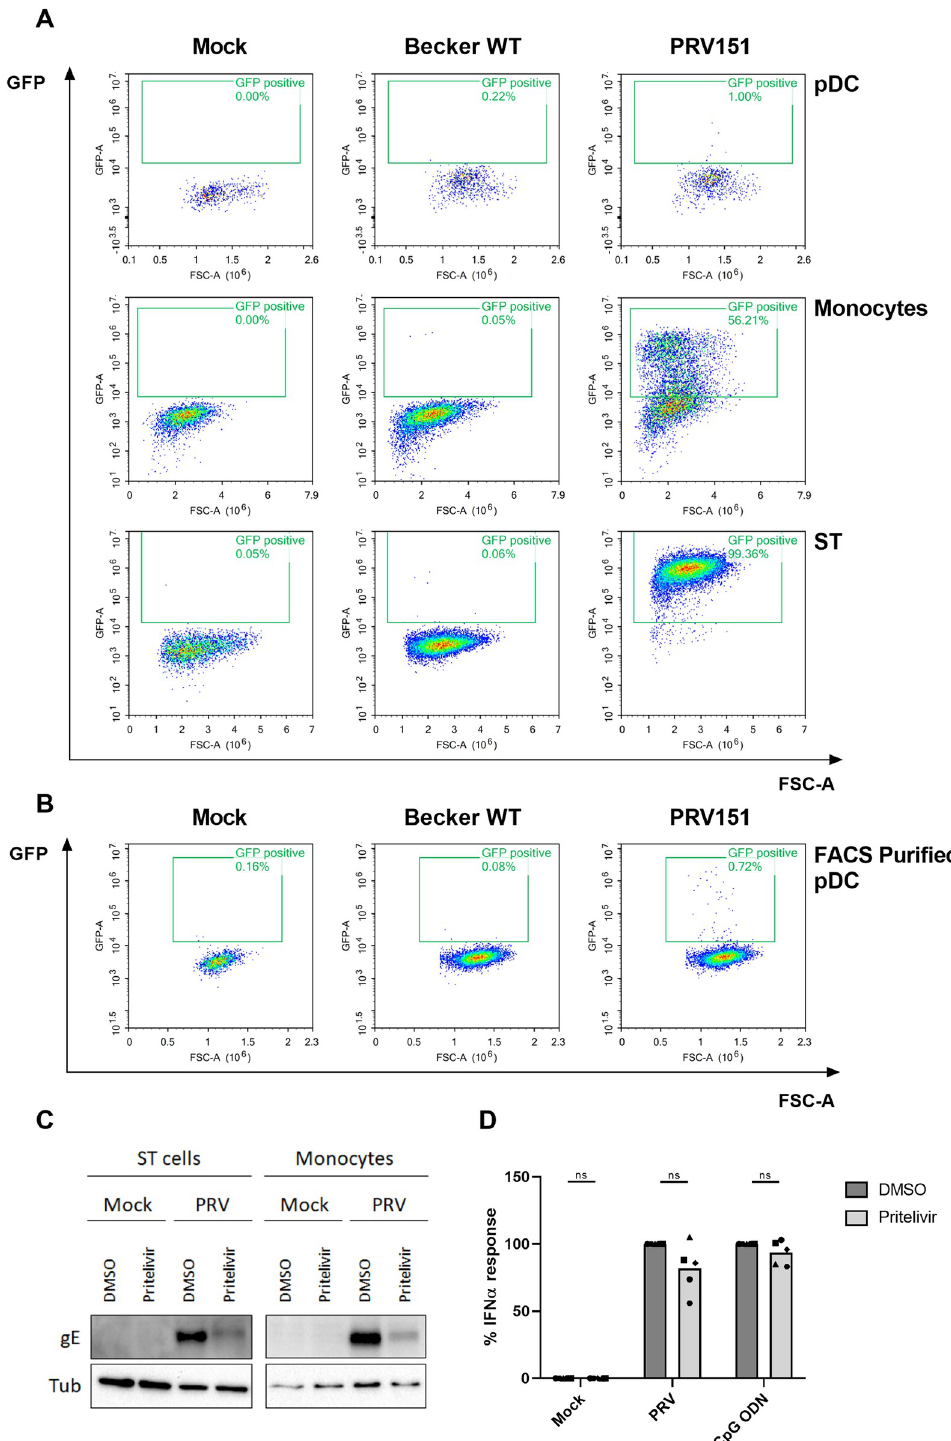
Fig 2. pDC are poorly susceptible to PRV infection and virus replication is not required for pDC activation. (A) Porcine PBMC, monocytes or ST cells were mock inoculated or inoculated with WT PRV Becker or the isogenic GFP- expressing PRV virus PRV151 (MOI 10) as mentioned in the materials and methods and 24h later analyzed for GFP expression by flow cytometry. pDC were gated from the PBMC population according to their CD4 high CD172a dim phenotype. One representative example out of four replicates is shown. (B) FACS purified porcine pDC were